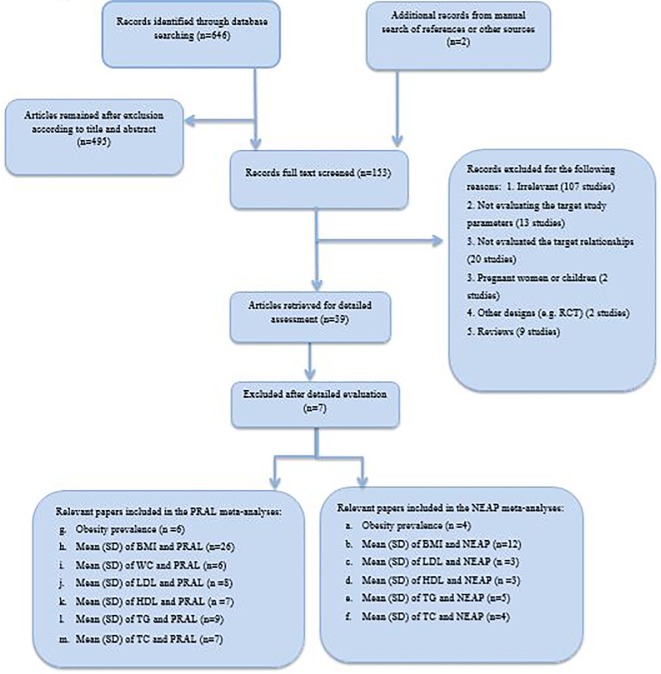
Flow diagram of study screening and selection process.